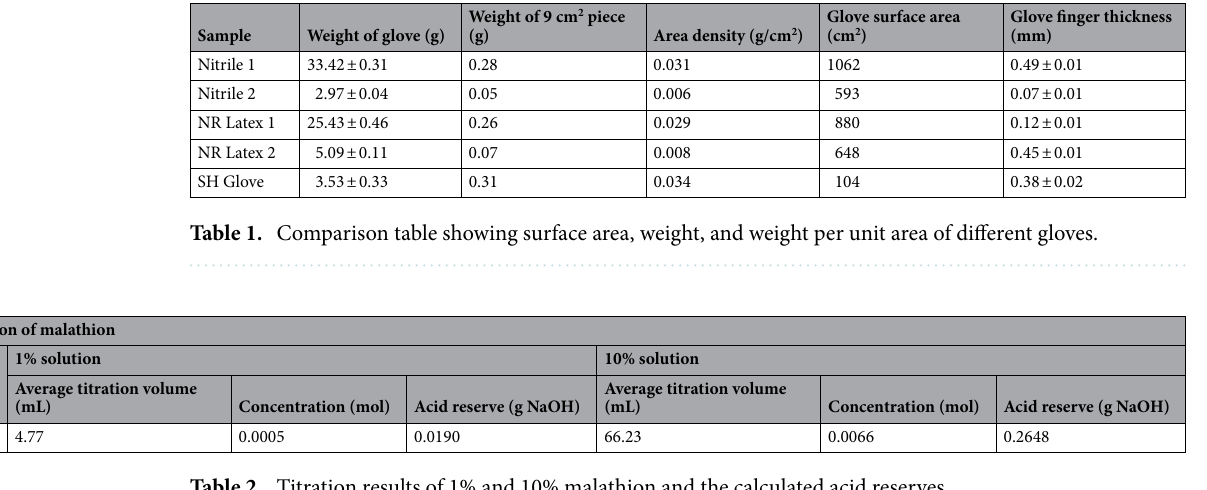
Table 2. Titration results of 1% and 10% malathion and the calculated acid reserves.